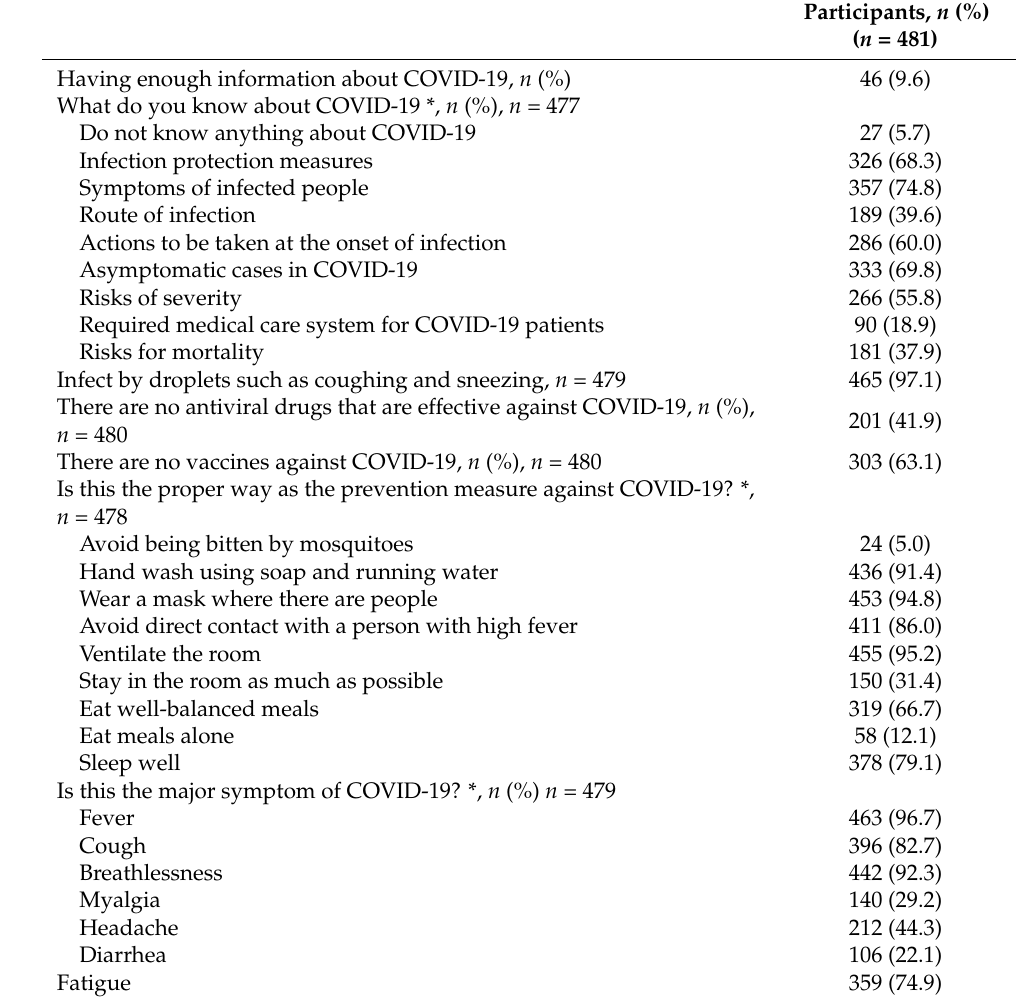
Table 2. Knowledge relating to COVID-19 among nursing care